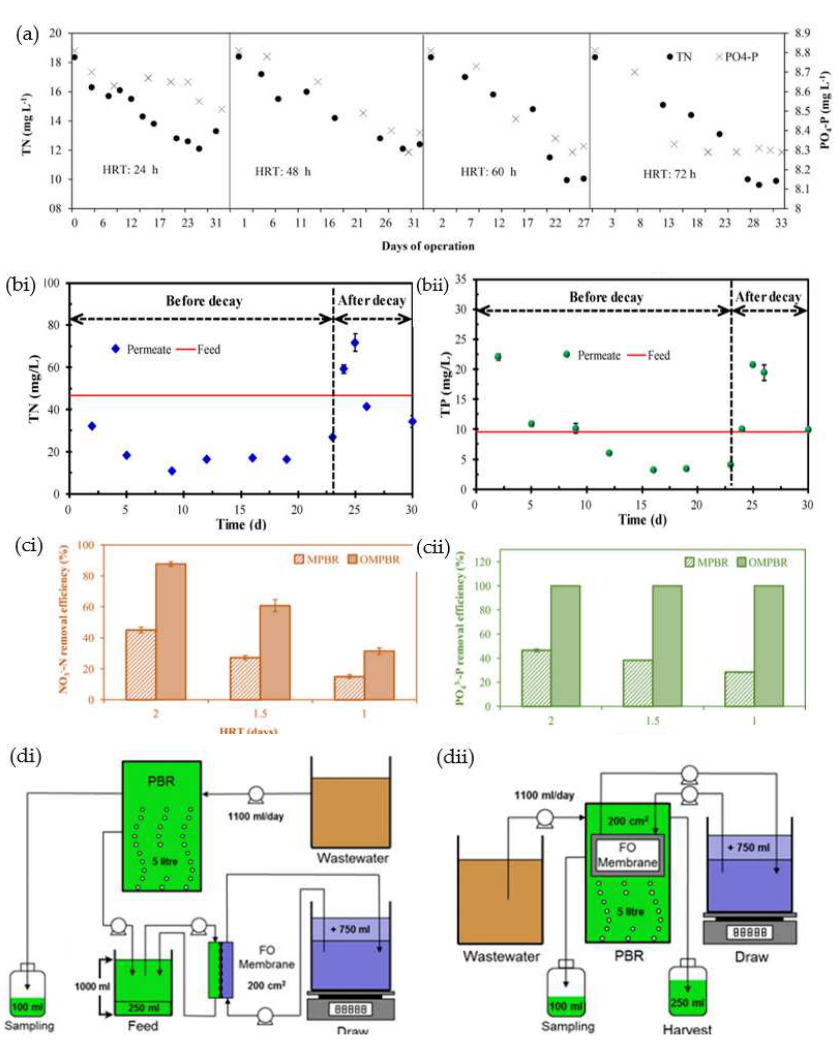
Figure 2. ( a ) Concentrations of total nitrogen and PO 43 P in the effluent of the MPBR operated with different HRTs [104]. ( b ) Concentration of (i) total nitrogen and (ii) total phosphorus before and after the decay of microalgae in the MPBR operated under a long HRT [105]. ( c ) Removal efficiencies of